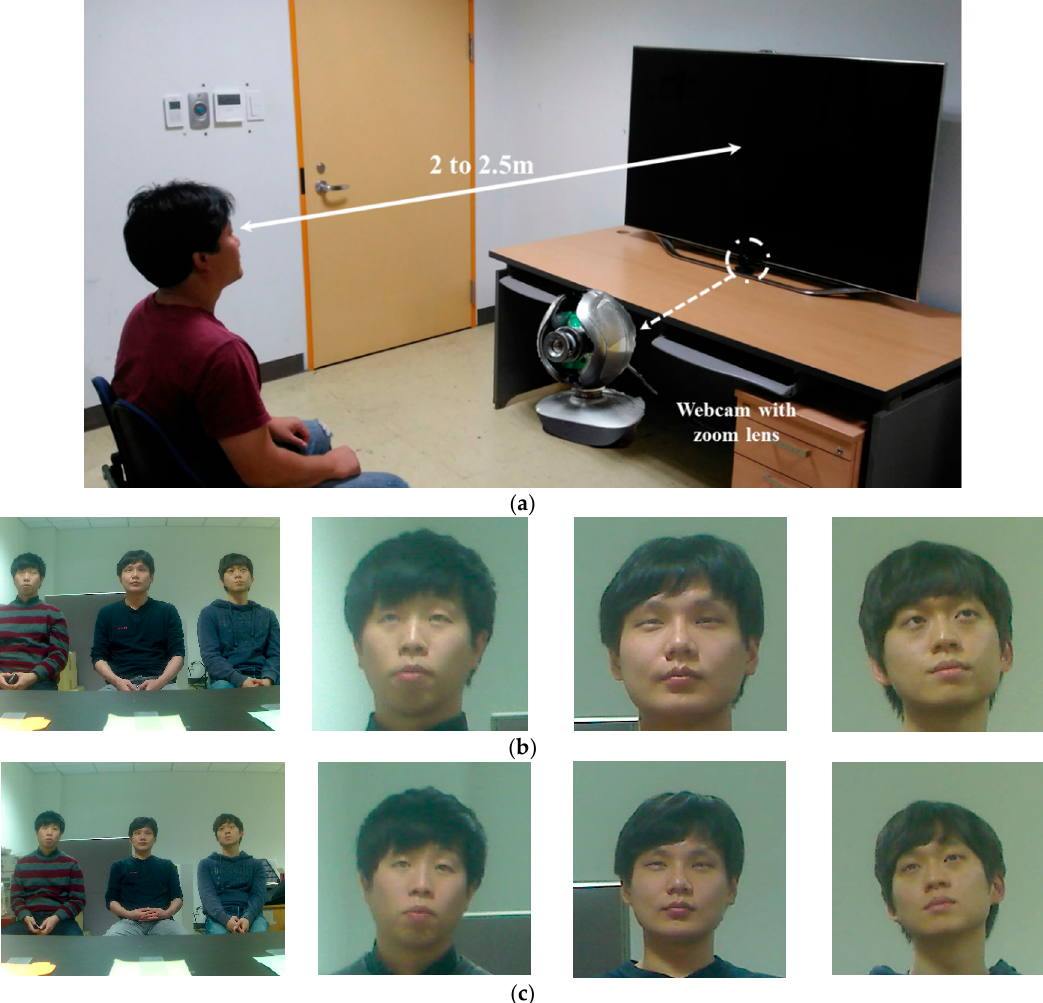
Figure 3. DB1 acquisition environment and obtained images: ( a ) experimental environment; ( b ) obtained images ( left : Image captured at a distance of 2 m; right : The face images cropped from the images on the left); ( c ) obtained images ( left : the image captured at a distance of 2.5 m, right : the face images cropped from the images on the left).